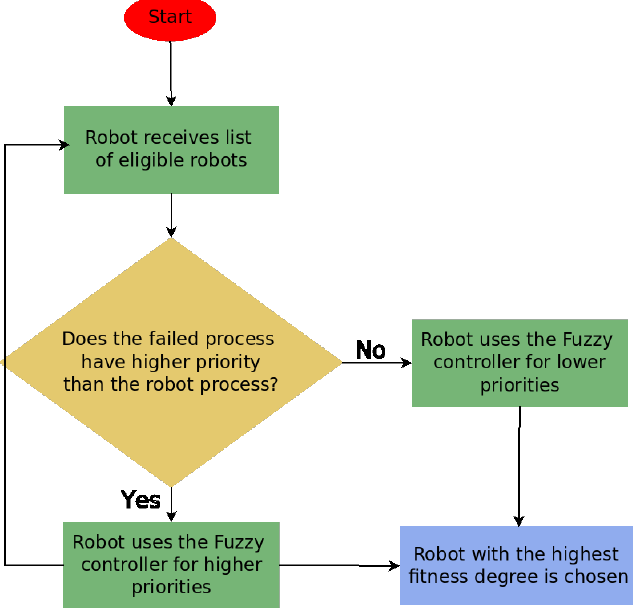
Figure 4. Flowchart referring to Fuzzy controllers for higher and lower